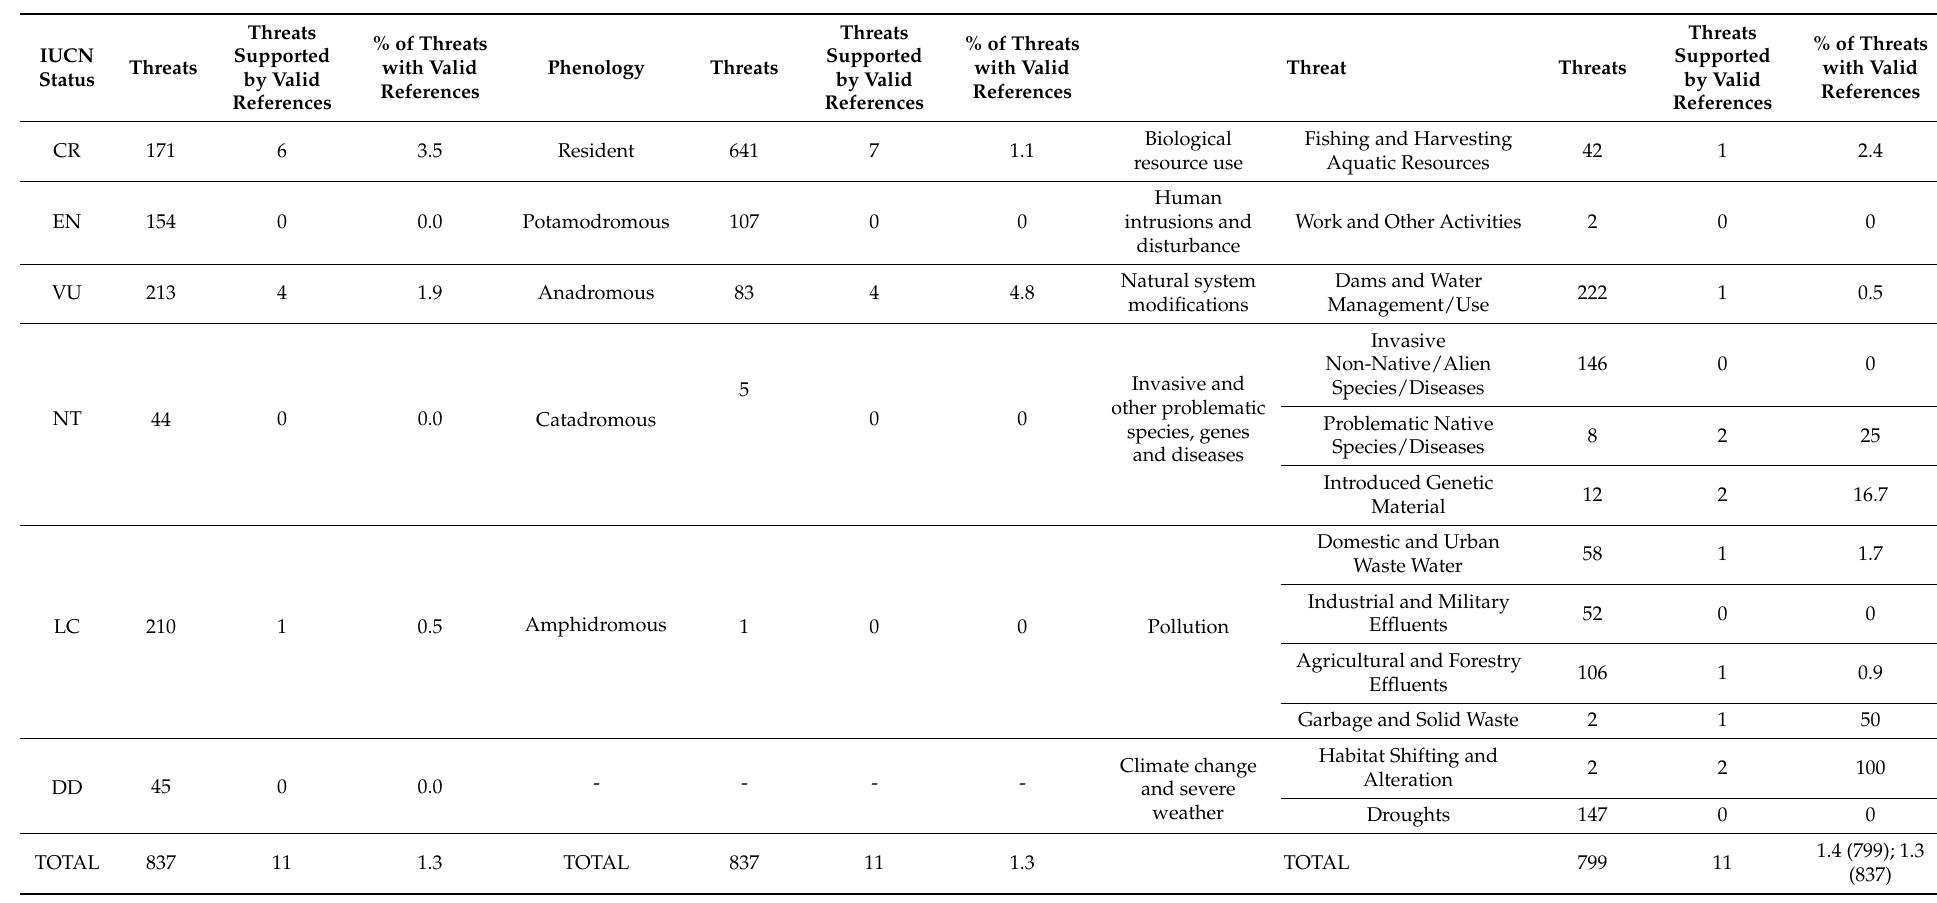
Table 1. Number of identified threats, number of threats supported by valid references (the literature is considered valid after assessing the information present in the document in relation to the threat referenced by it) and % of threats that are supported by a valid reference, classified according to the International Union for Conservation of Nature Red List species assessment (IUCN) Status, Migratory phenology (Phenology) and Threat typology (Threat). Here, only typologies with references in the IUCN Red List site were analysed. Thus, the total was not the same. In this table, all references and literature elements were considered, and literature not available were considered non-valid references herein. Critically Endangered (CR), Endangered (EN), Vulnerable (VU), Near Threatened (NT), Least Concern (LC) and Data Deficient